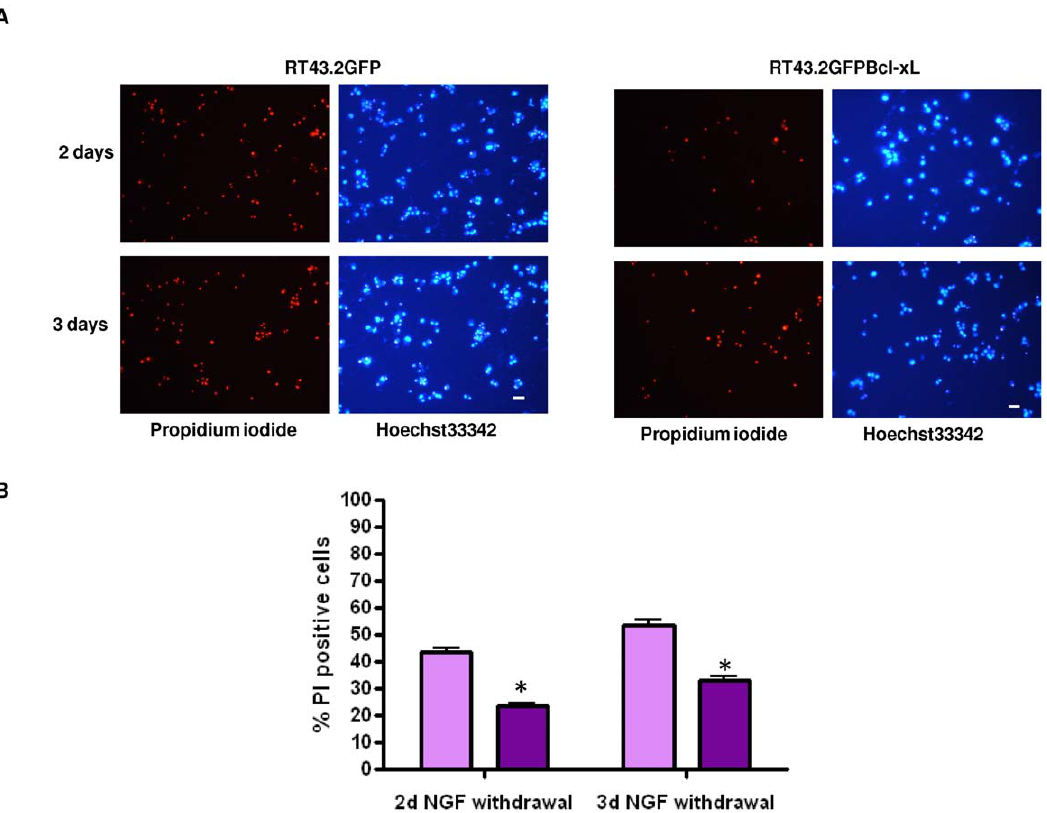
Figure 7. PC12 cells expressing Bcl-xL demonstrated reduced NGF-withdrawal induced death. A . Undifferentiated PC12 cells on Matrigel-coated wells were transduced with control RT43.2GFP (left four panels) or RT43.2GFPBcl-xL vectors (right four panels), differentiated with 100 ng/ml NGF for five days, and then NGF was withdrawn for either 2 (upper panels) or 3 days (lower panels) after which PI was used to stain dead cells and total cell count was obtained by Hoechst33342 staining. The cells were photographed with a 20 6 objective using either a rhodamine or DAPI filter. Scale bars=20 m m. B . PI stained dead cells and Hoechst33342 stained total cells were used to determine the effects of GFPBcl-xL expression (dark purple) compared to GFP expression alone (light purple) on cell viability. Percentage of PI positive cells versus Hoechst 33342 stained total cells is represented by the mean value of several fields obtained from three experiments. *P , 0.01. Figure 9B corresponds to an MOI of 8) than that previously used to show growth-arrested cell lines are resistant to MLV retroviral